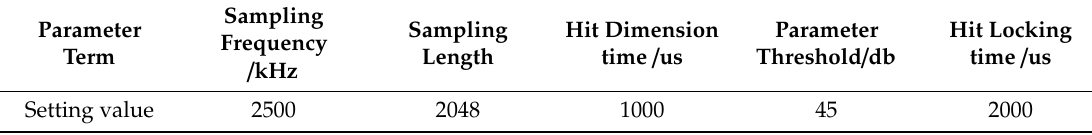
Table 2. The parameters of acoustic emission ( AE) system.